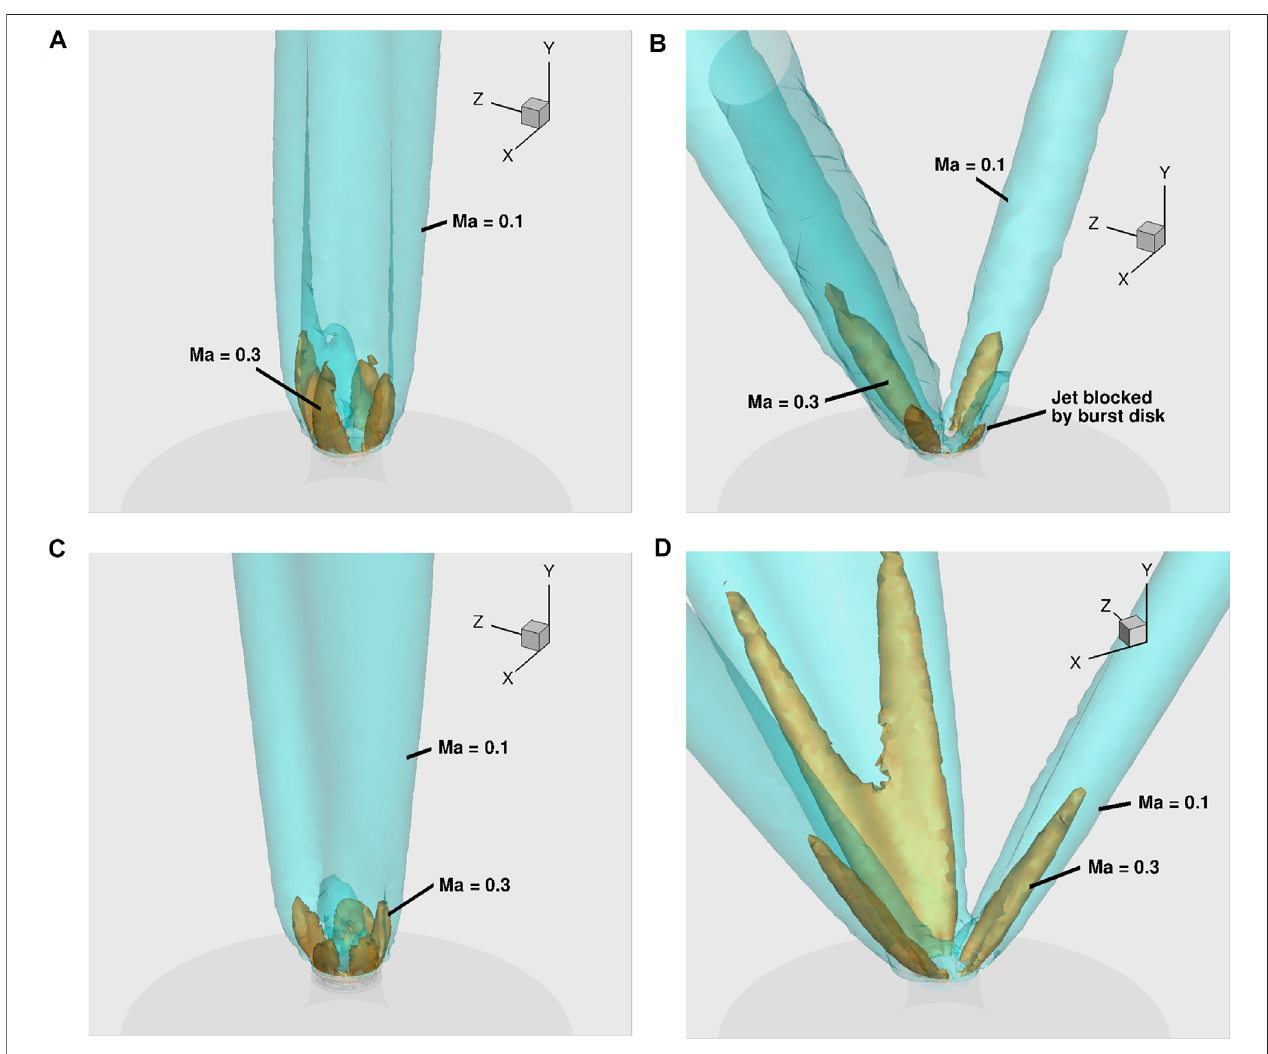
FIGURE 7 | RANS simulated Mach number isosurfaces at P 1 /P 2 (cid:1) 7: MTI (A) , LG MJ1 (B) , K2 (C) , and LG M36 (D) .